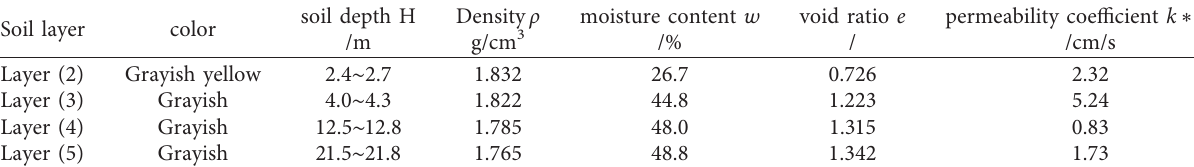
Table 3: Soil layer distribution and basic physical and mechanical indexes.